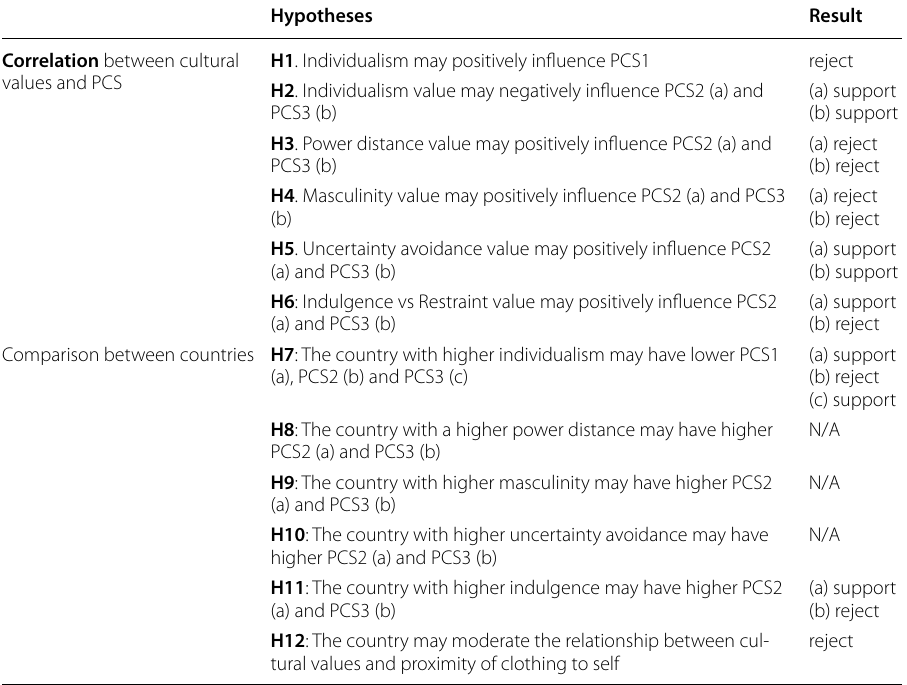
Table 5 Hypotheses testing